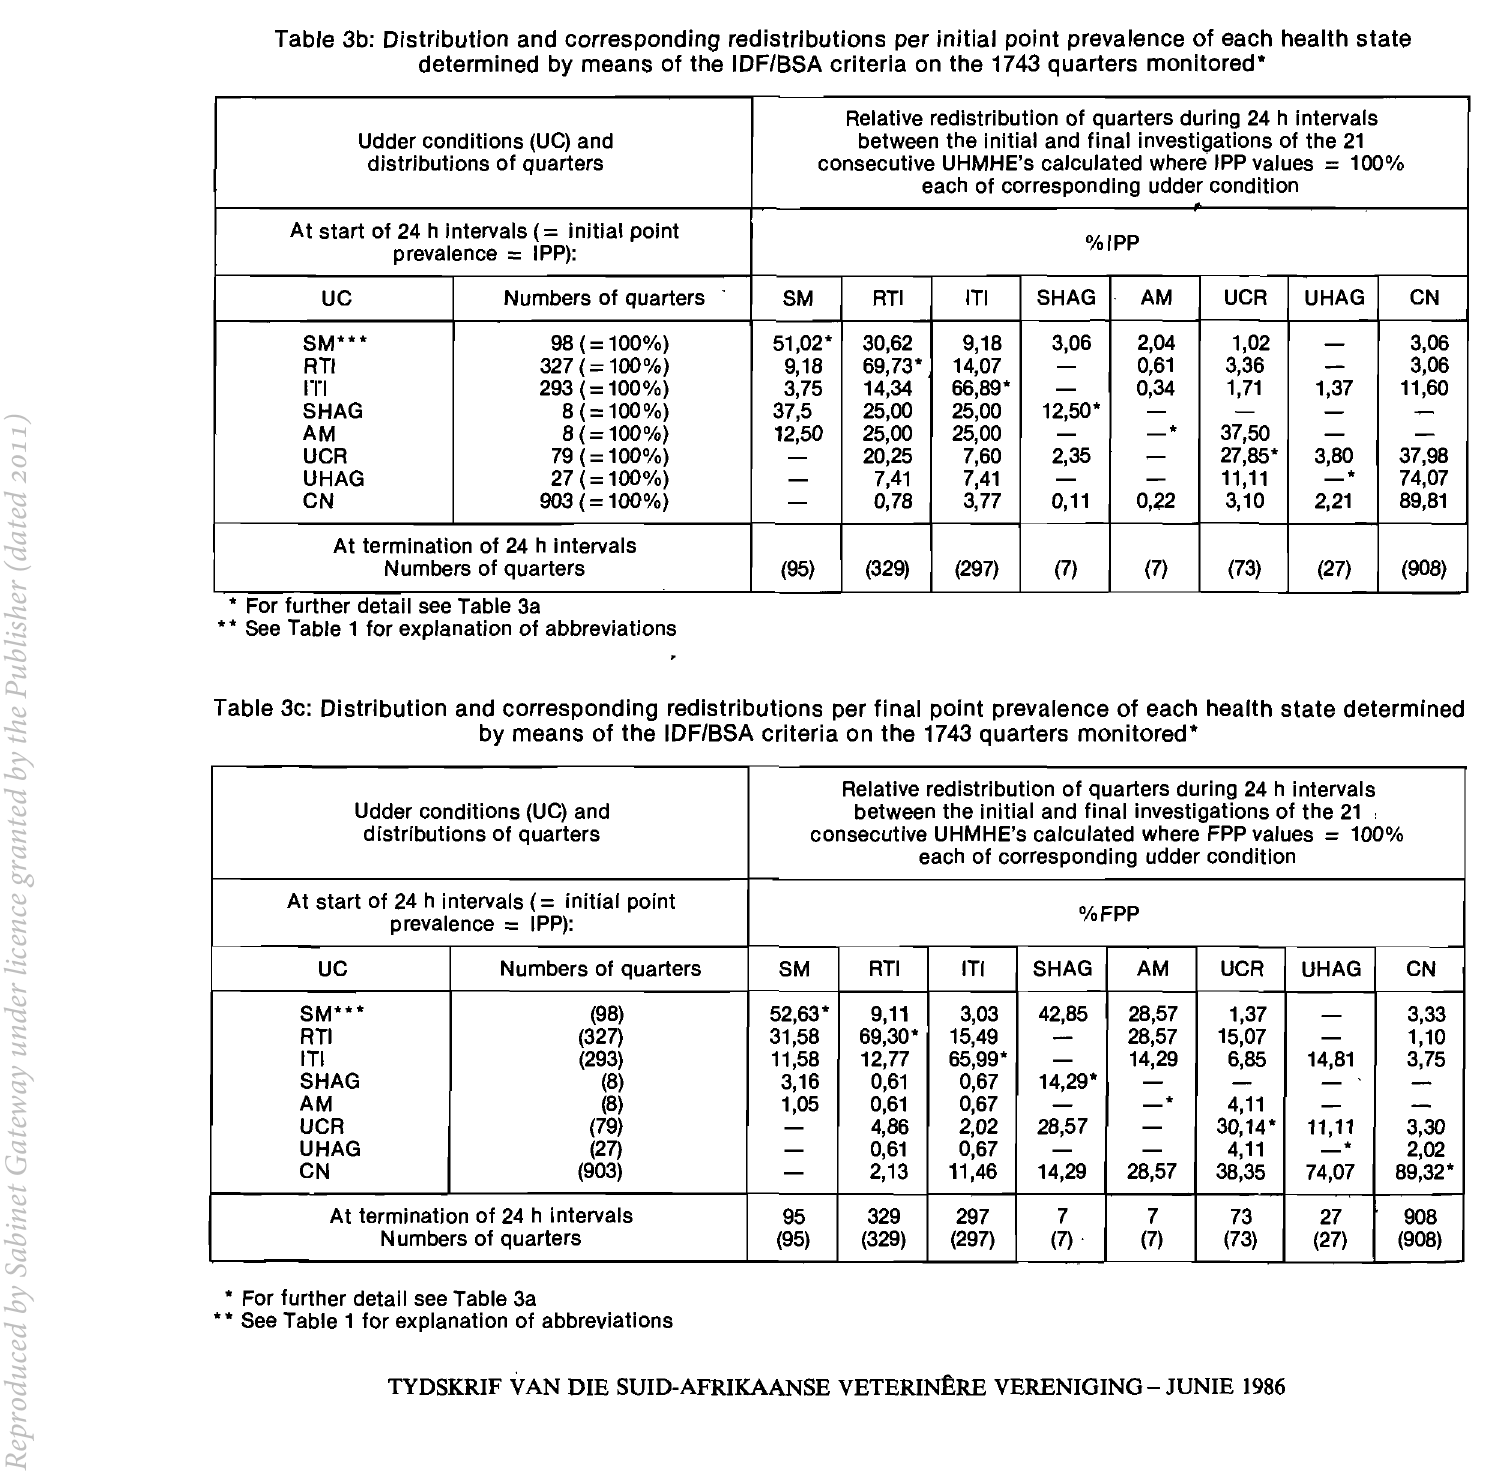
Table 3b: Distribution and corresponding redistributions per initial pOint prevalence of each health state determined by means of the IDF/BSA criteria on the 1743 quarters monitored* Relative redistribution of quarters during 24 h intervals Udder conditions (UC) and between the initial and final investigations of the 21 distributions of quarters consecutive UHMHE's calculated where IPP values = 100% each of corresponding udder condition At start of 24 h intervals (= initial point %IPP prevalence = IPP):